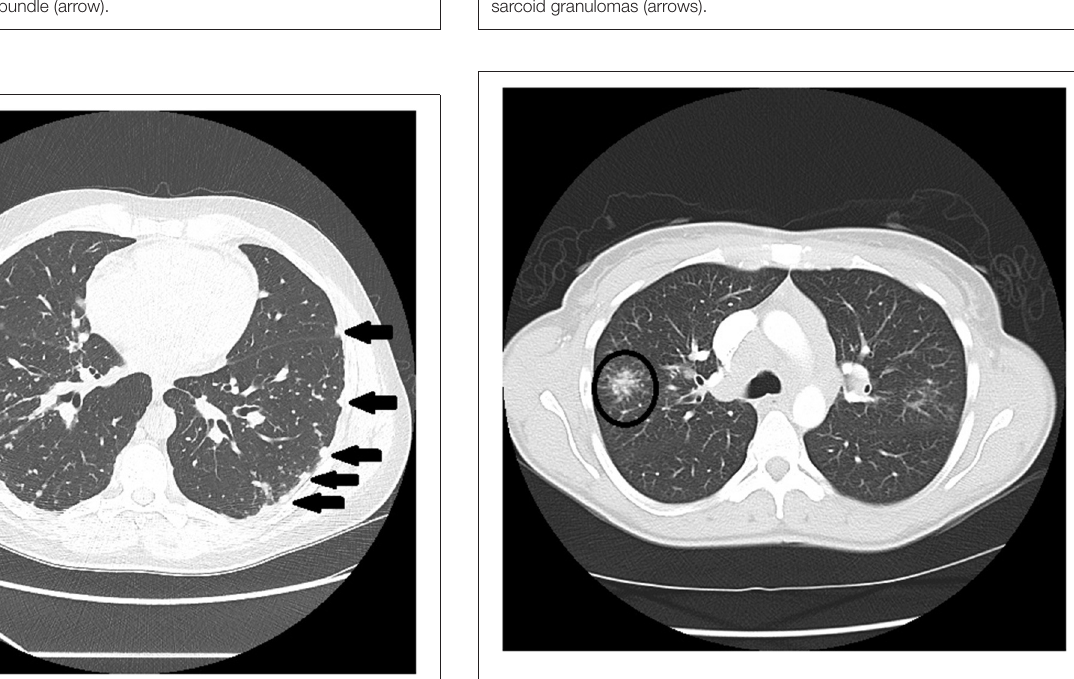
findings is unreliable and generally not recommended.